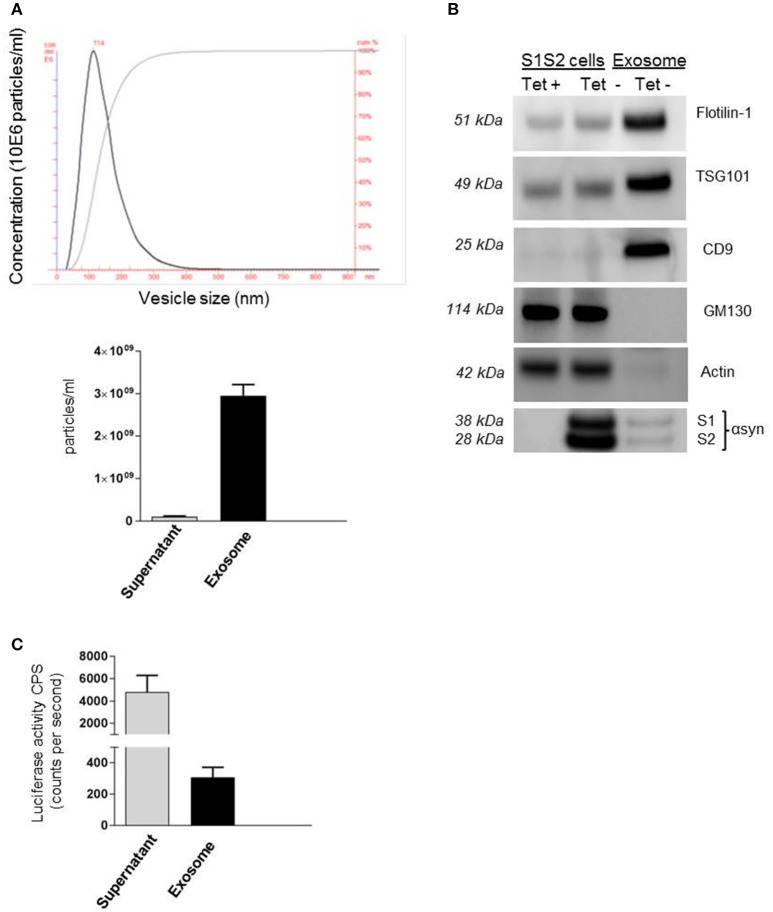
Detection of αsyn oligomers in SL1 SL2 human neurogliomal cell derived -exosome. (A) Characterization of H4-derived vesicles by nanoparticle tracking; (Top) Representative particle size distribution of exosome preparation; (bottom) Average concentration of nano vesicles in the exosomal fraction as well as in the supernatant. (B) Immunoblot analysis of SL1SL2 cells and exosome-like vesicles for the exosomal markers flotillin-1, CD9, TSG101, the ER marker GM130, and Actin. αSyn was detected with an antibody speficic for human αsyn (clone 4B12) in the cell line and in the exosome (C) αsyn oligomers detection via luciferase assay in the supernatant and exosomes isolated from Sl1 to Sl2 cell line.